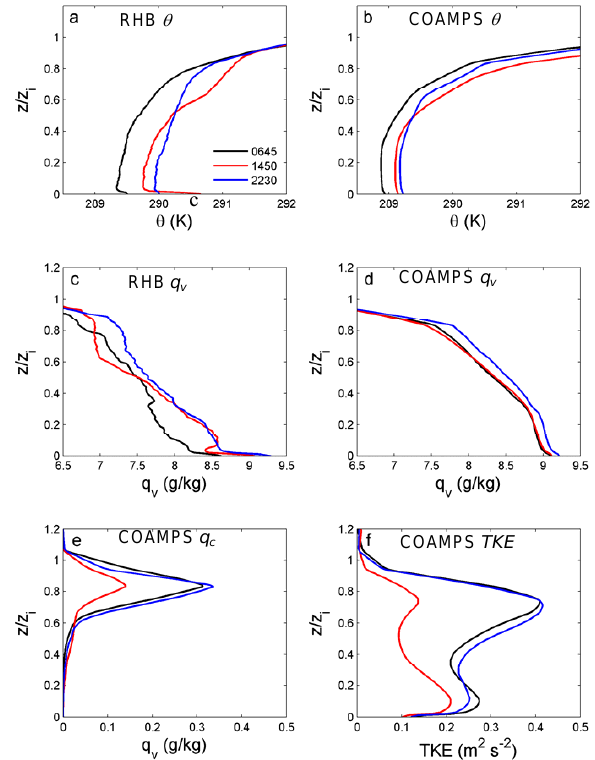
Fig. 14. Diurnal variation of normalized profiles from the RHB observations and the COAMPS forecasts. (a) RHB θ ; (b) COAMPS θ ; (c) RHB q v ; (d) COAMPS q v ; (e) COAMPS q c ; and (f) COAMPS TKE . The numbers in (a) denote local time of the soundings defined by the different colors.